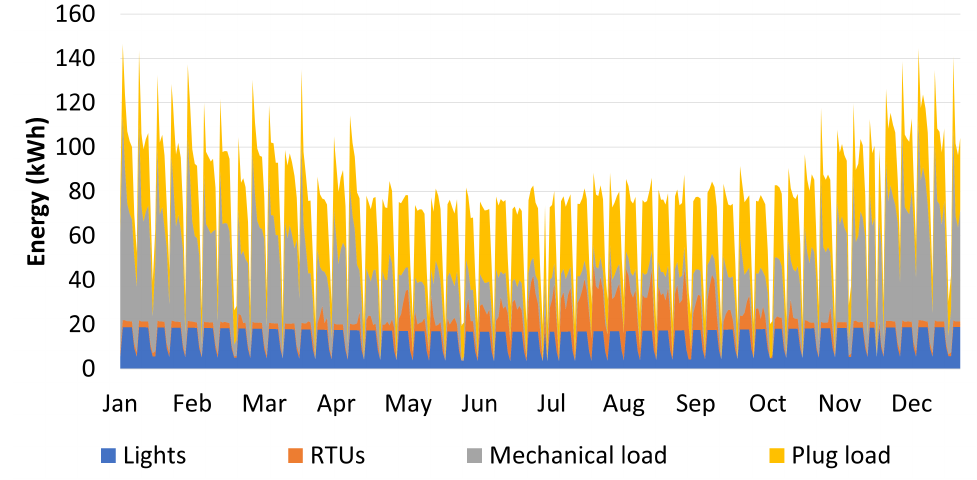
Figure 6. Yearly load profile (daily average) for different building components.